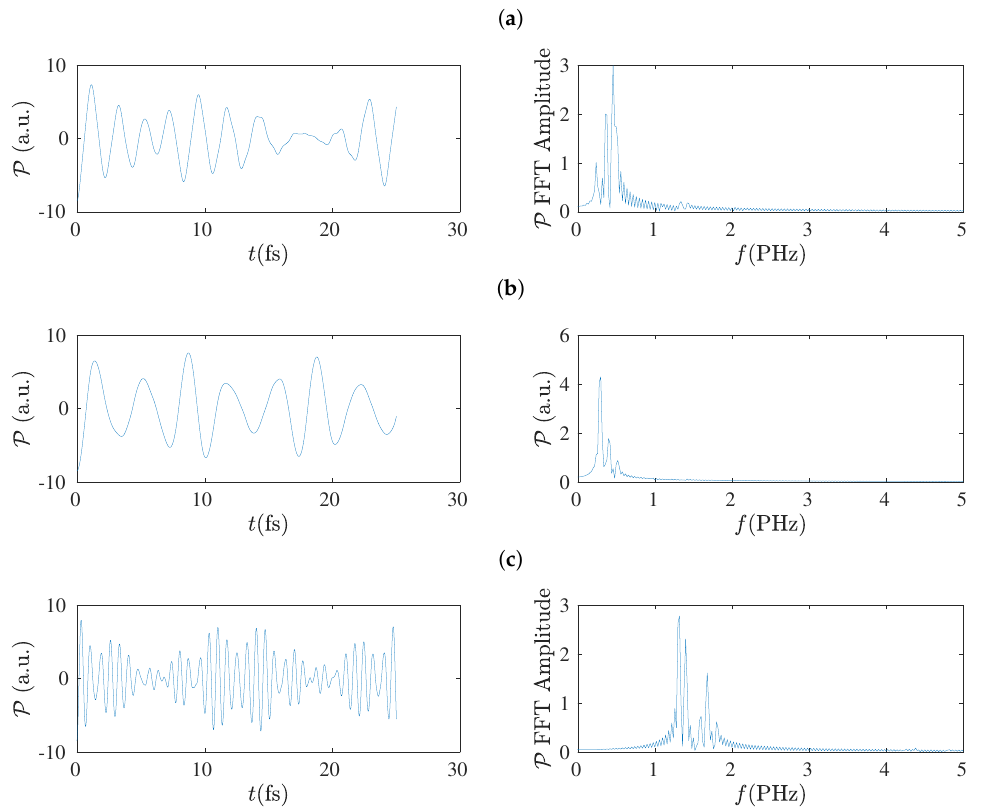
Figure 20. Left column: Dipole moment ( P ) oscillations obtained by the TB variants ( a ) TBI, ( b ) TBImod, ( c ) TBImodt4times, for N = 8. Right column: The corresponding FFT amplitudes obtained by MATLAB without any further